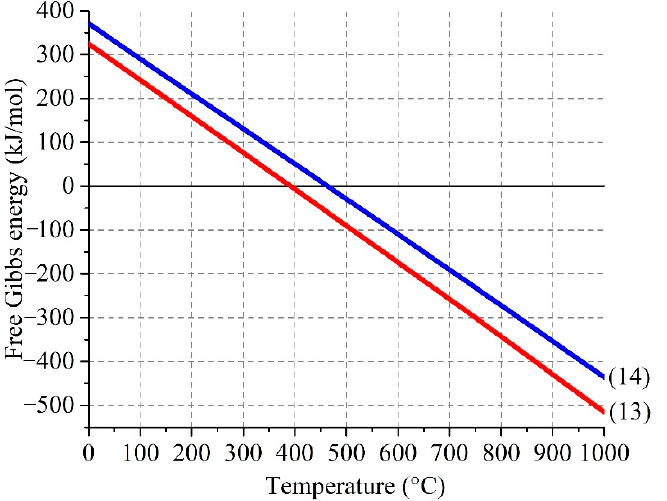
Figure 15. Effect of temperature on Gibbs free energy of the interactions of ferric sulfate with zinc (4) and copper (5)